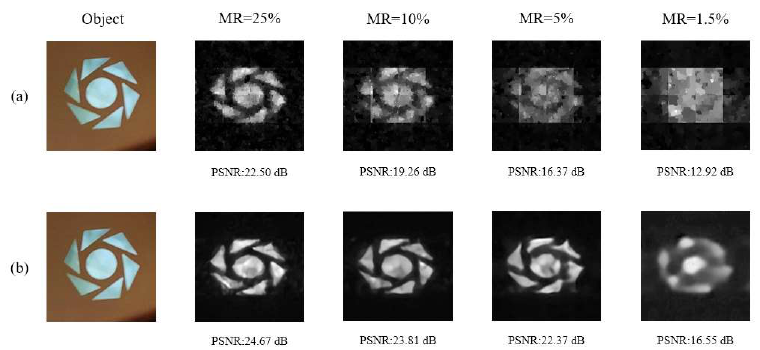
Figure 8. Single-pixel imaging results using the traditional method and the proposed method. ( a ) The reconstruction algorithm is TVAL3. ( b ) The reconstruction algorithm is SRMU-Net.